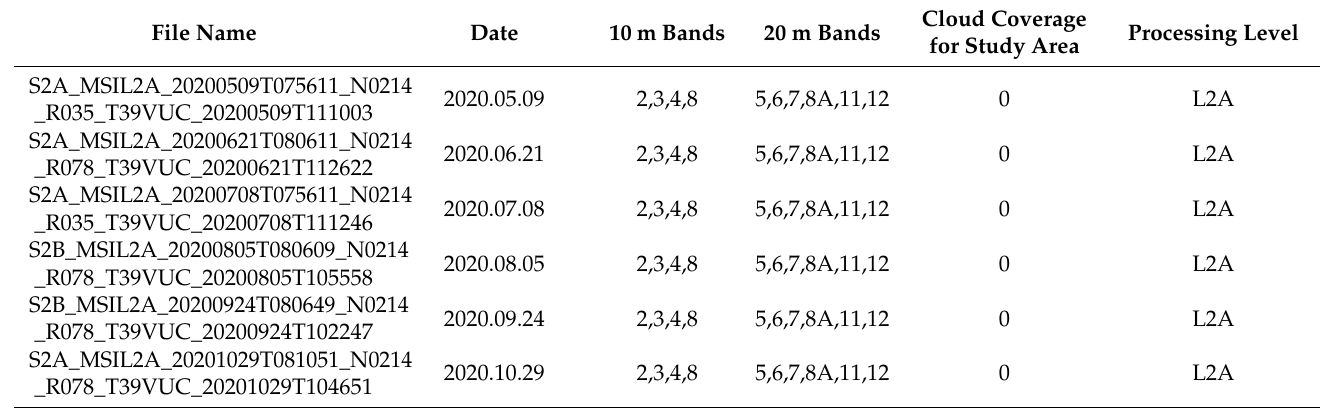
Table 2. Sentinel-2 images. Spectral bands: Band 2—Blue, 458–523 nm; Band 3—Green, 543–578 nm; Band 4—Red, 650–680 nm; Band 5—Red-edge I, 698–713 nm; Band 6—Red-edge II, 733–748 nm; Band 7—Red-edge III, 773–793 nm; Band 8—Near infrared (NIR), 785–900 nm; Band 8A—Narrow Near infrared (NNIR), 855–875 nm; Band 11—Shortwave infrared-1 (SWIR1), 1566–1651 nm; Band 12—Shortwave infrared-2 (SWIR2), 2100–2280